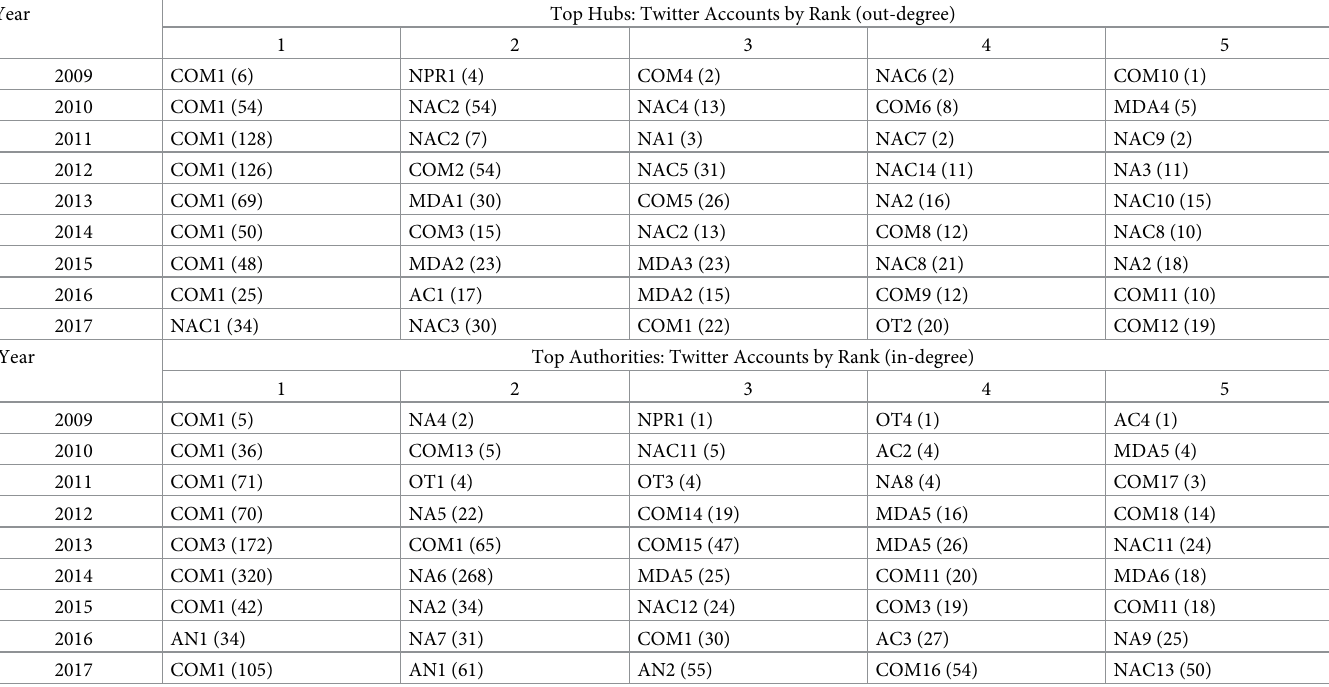
Table 4. Ranking of top Twitter accounts by out-degree and in-degree frequencies used as surrogates to identify hubs and authorities respectively within the UK probiotcs network. Year Top Hubs: Twitter Accounts by Rank (out-degree) 1 2 3 4